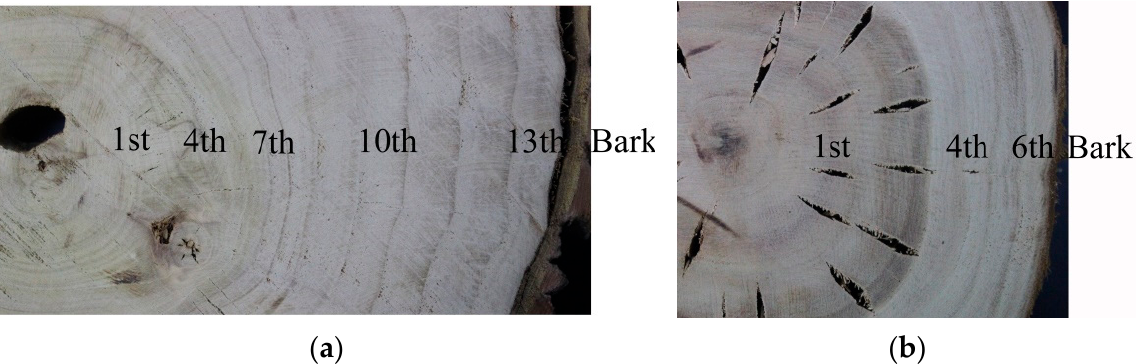
Figure 3. ( a ) The photo of poplar rings; ( b ) the photo of eucalyptus rings. The barks and each ring are marked on the photos.